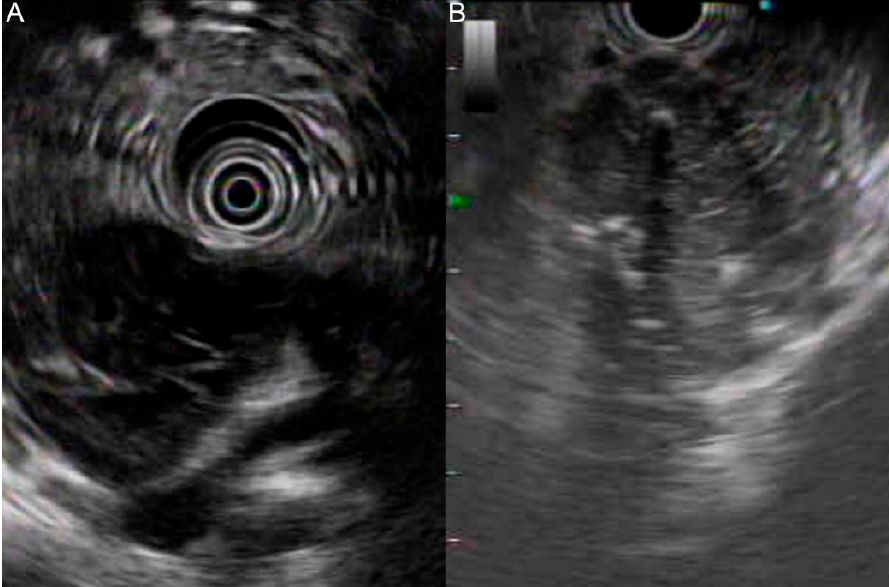
Figure 2. EUS demonstrating a heterogeneous hypoechoic lesion with a cystic component at the pancreatic head ( A ) in the presence of calcifications ( B ).